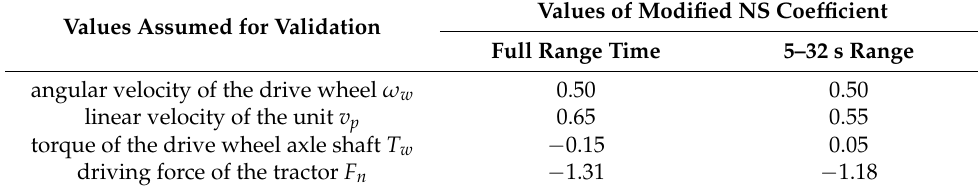
Table 1. Value of the modified Nash–Sutcliffe (NS)